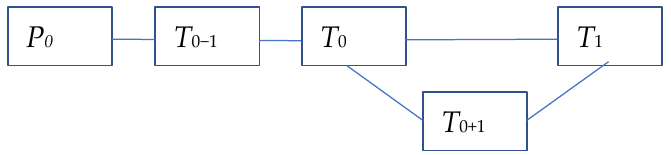
Figure 10. Topology of thermal relations of the inner part of the calorimeter.